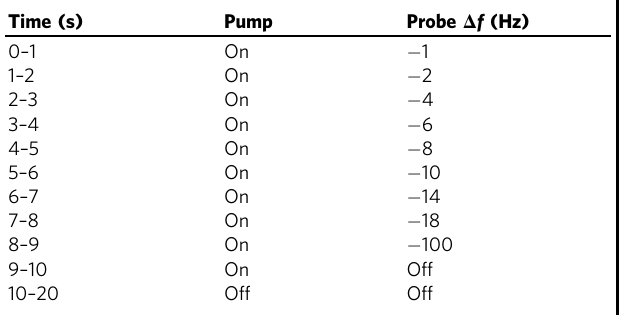
Table 2 Transmitter experimental cycle.